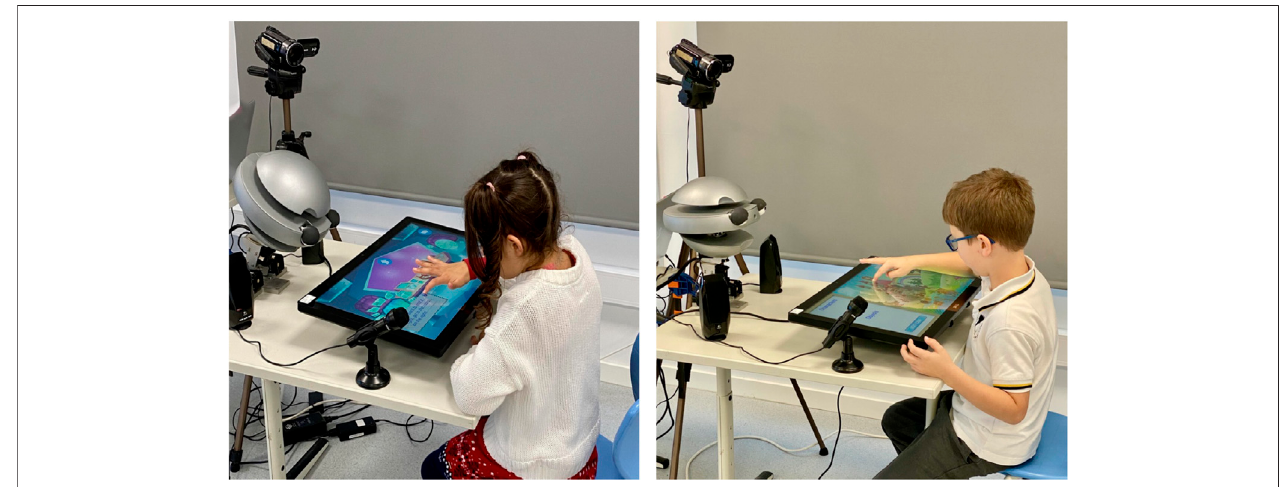
FIGURE 2 | Children interacting with the robot during the interactive – collaborative activity.